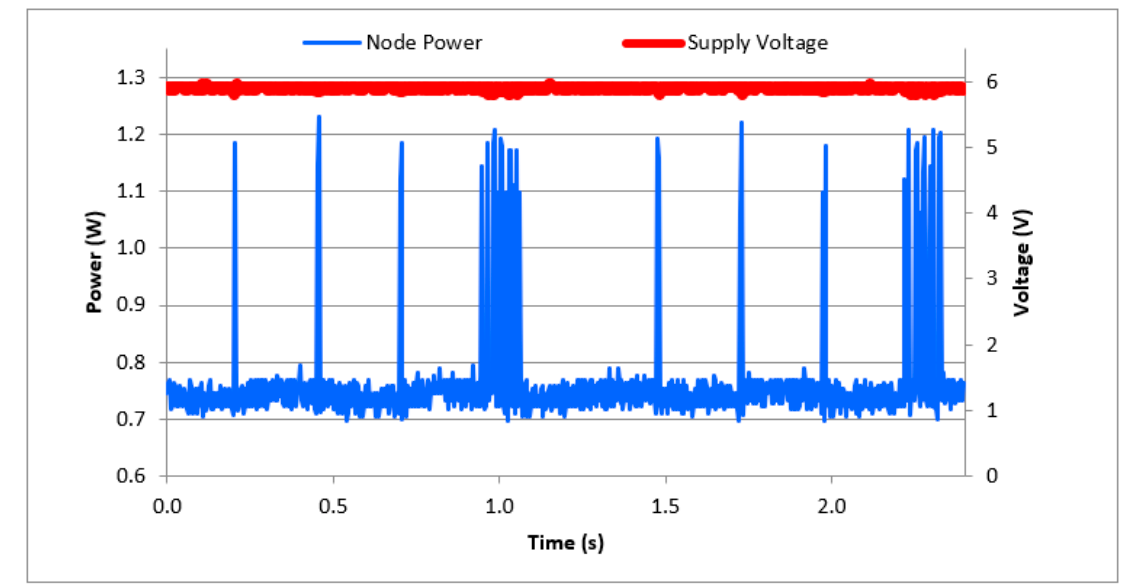
Figure 12. Power consumption of the sensor node during image capture, processing, and transmission operations.